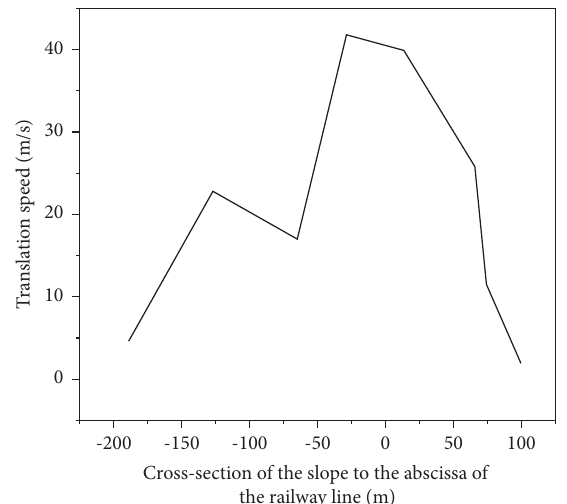
Figure 5: Translation velocity curves of falling rock from section 1 to section